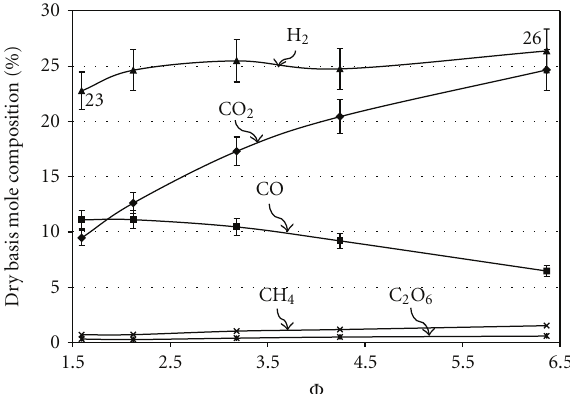
Figure 5: Gas composition of DBWC gasification at S : F = 0.80 and several Φ s, adapted from [11].